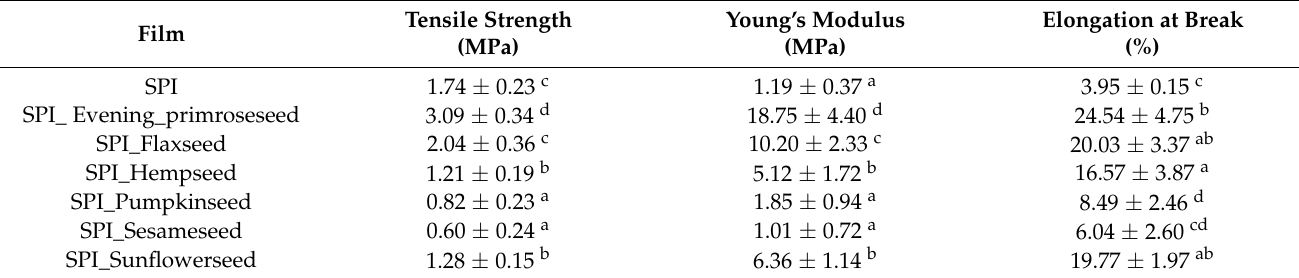
Table 4. Mechanical properties of films prepared with oilseed